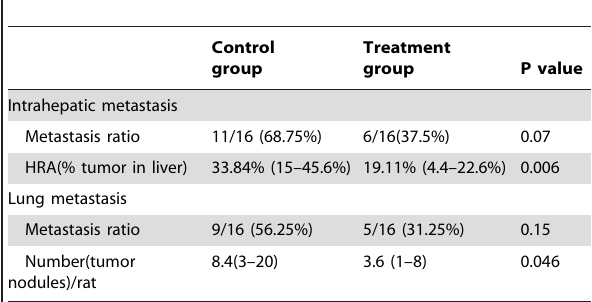
Table 1. Comparison of tumor metastasis after liver resection and I/R